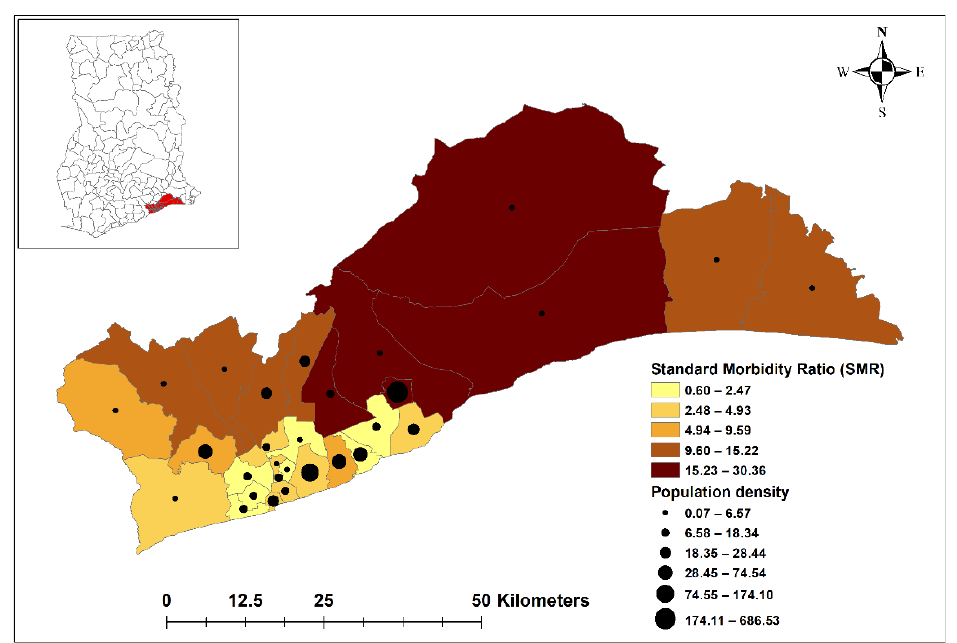
Figure 2. Standard morbidity ratios (SMRs) and population densities per square km by district in the Greater Accra Region, 2015–2019. Source: Authors’ own contribution. 2015–2019. Source: Authors’ own